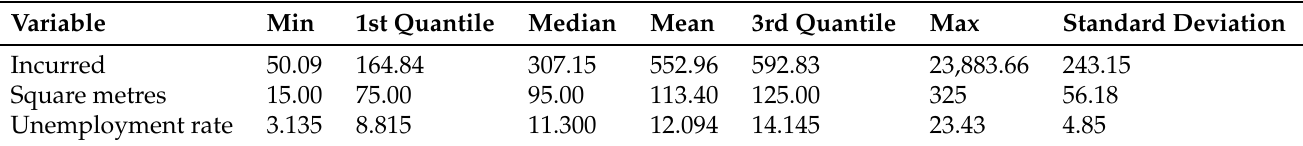
Table 1. Descriptive statistics of dependent and explanatory